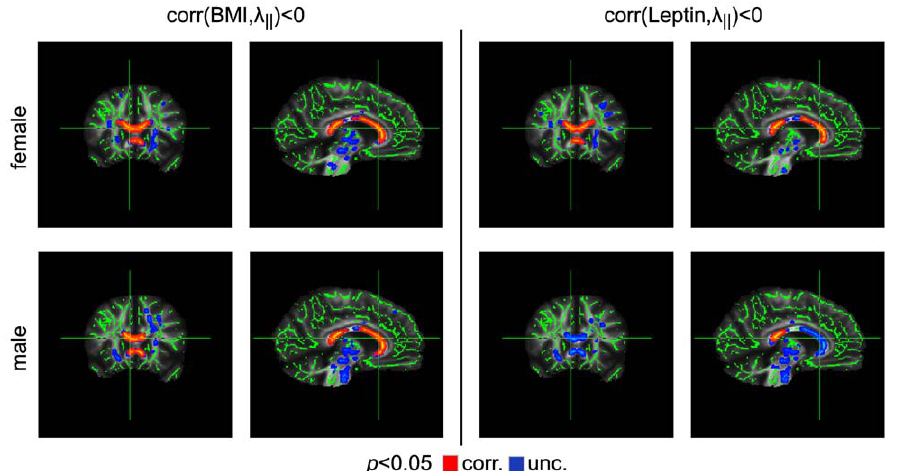
Figure 3. Correlation between l I and body weight using BMI (left) and leptin levels (right). For both women and men, we found a significant negative correlation between BMI and l I in all regions of the corpus callosum (both left columns). This result was again obtained by using the leptin level instead of BMI as an obesity marker (see right columns).